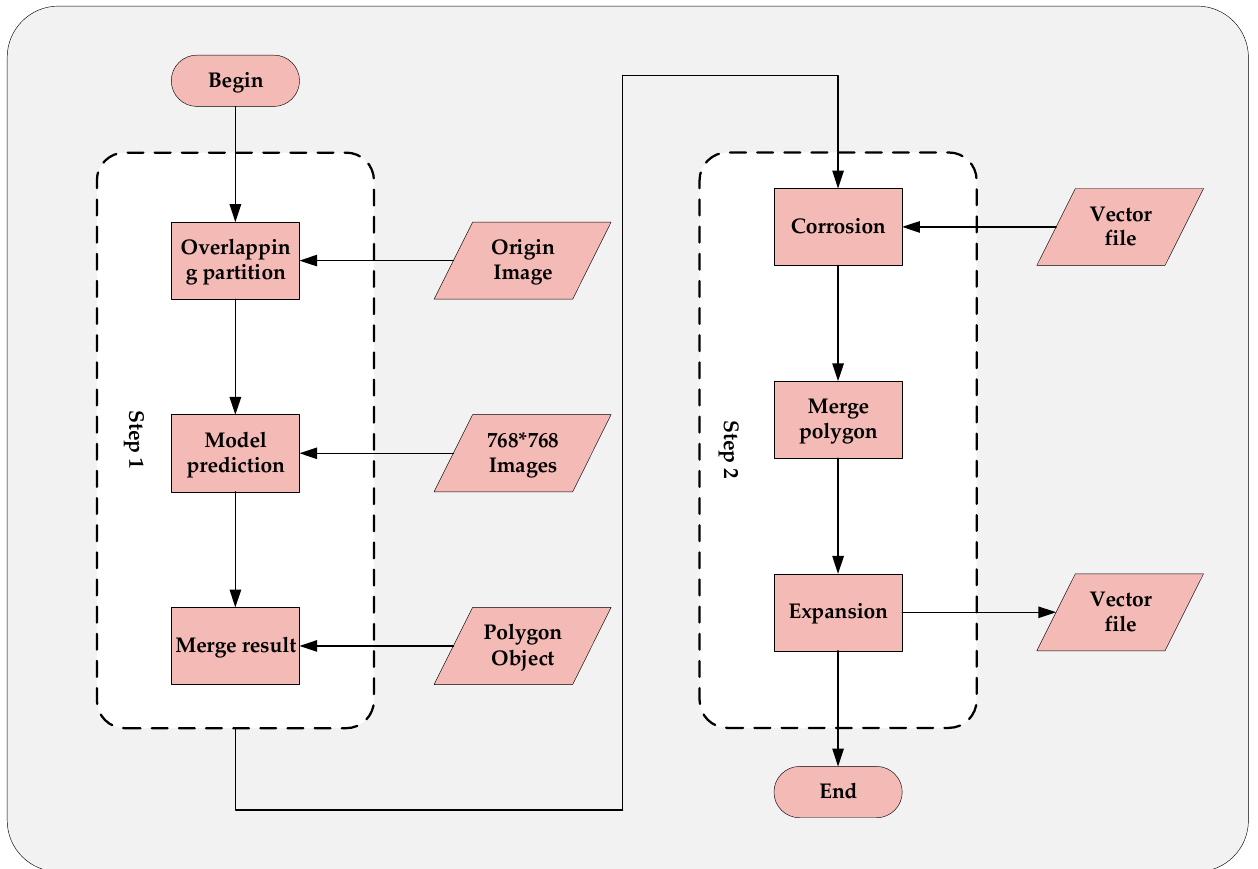
Figure 10. A flowchart for post-processing of merged fields from instance segmentation into a single vector file. The input is a large-sized remote sensing image and the output is the corresponding vector file.